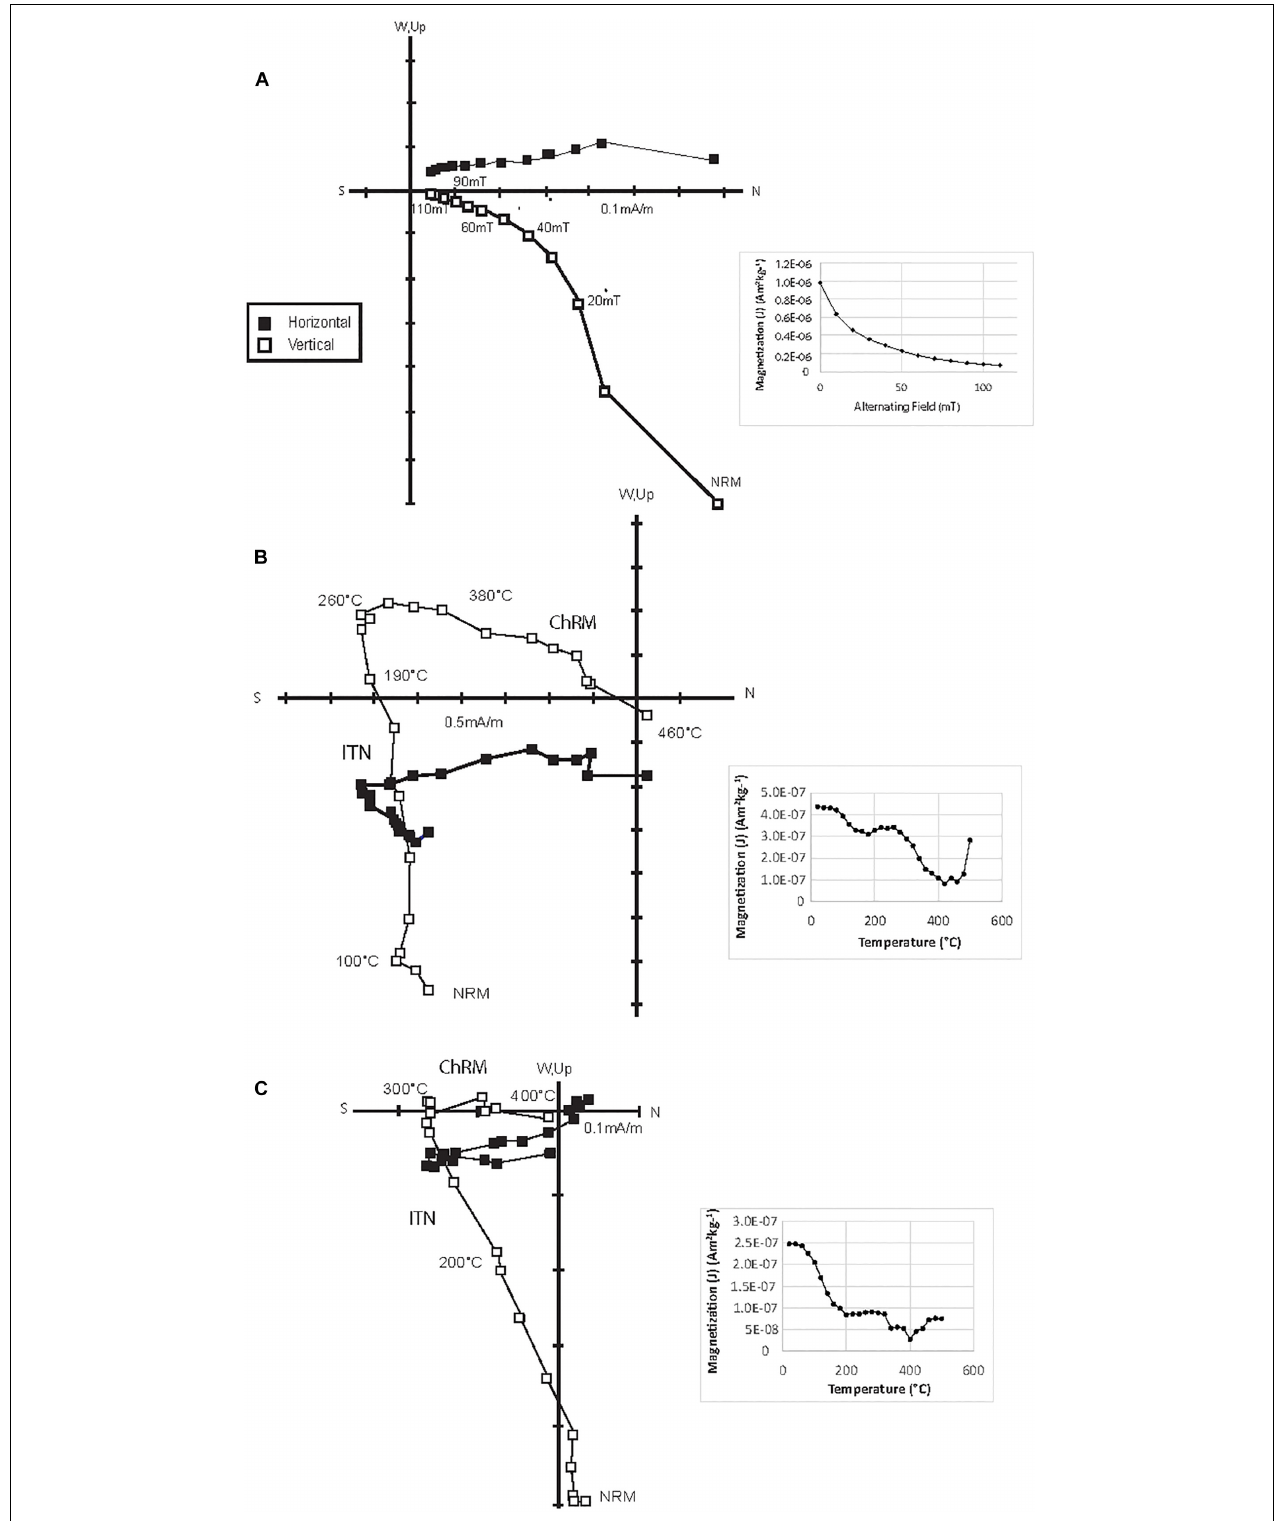
FIGURE 7 | Representative orthogonal projections and NRM decay plots for EC. (A) AF demagnetization of specimen from EC, (B,C) Thermal demagnetization of EC specimens showing the ITNs and the ChRMs. The magnetization increases above 500 ◦ C because of creation of new minerals (e.g., magnetite) and these temperature steps were removed from the orthogonal projection but not the thermal decay plot.